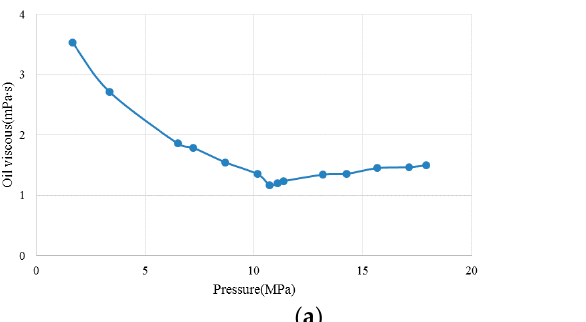
oil ratio pressure.